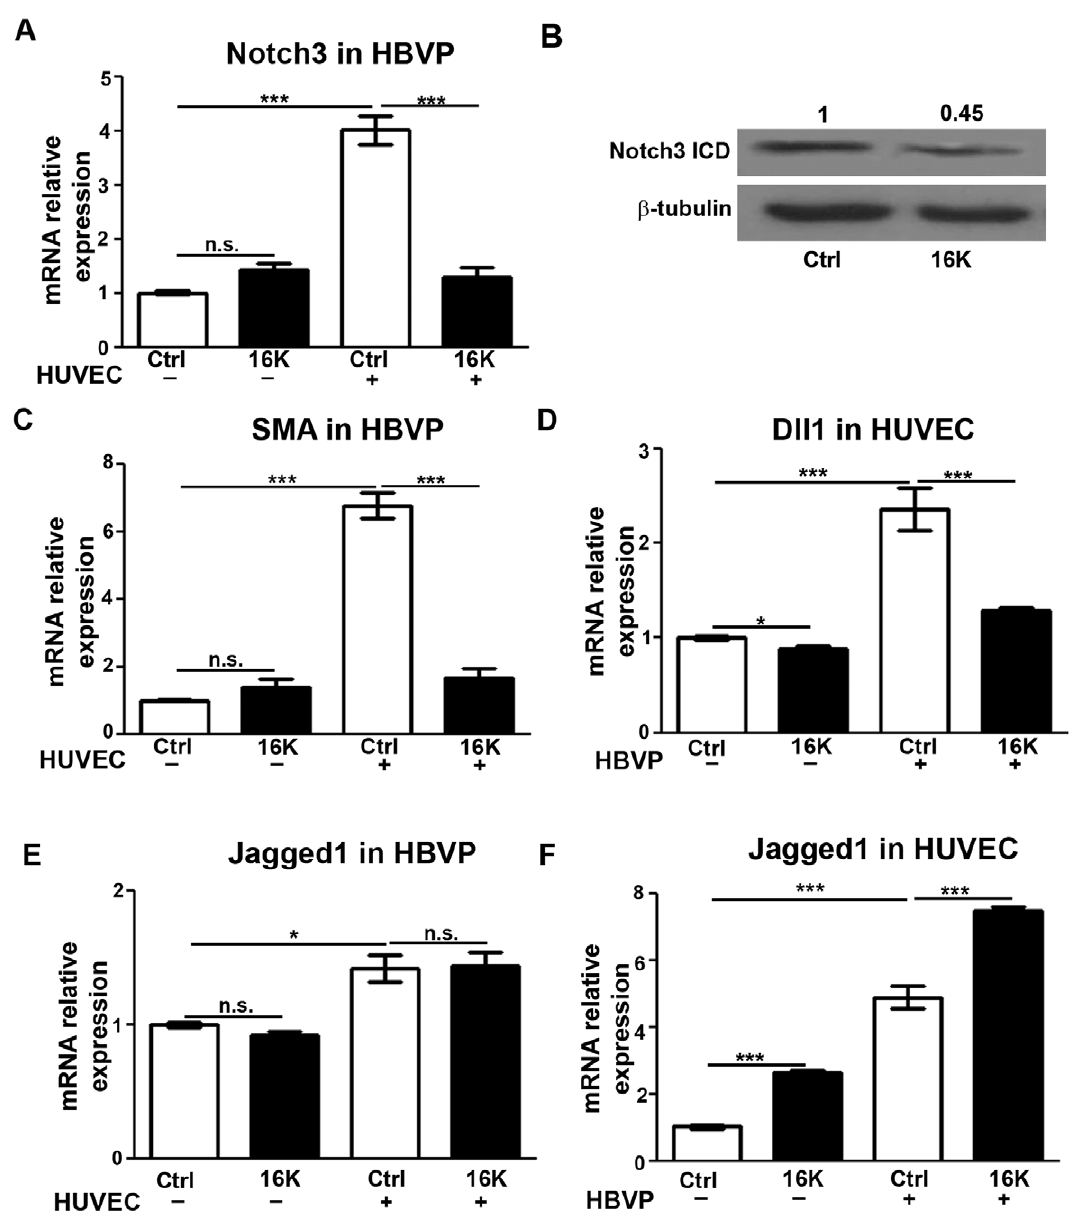
Figure 7. Decreased expression of Notch factors in HUVEC-HBVP cocultures after 16K hPRL treatment. In cultures of HBVP or HUVEC alone, the cells were treated with 100 nM 16K hPRL (16K) for 16 h. HBVP + HUVEC cocultures were seeded and treated as in Fig. 6, but the time spent in coculture was longer (16 h). The two cell populations were then separated prior to qRT-PCR analysis. In HBVP, transcripts of NOTCH3 and aSMA were detected (respectively A and C). Western blot analysis was also performed to detect Notch3 ICD (B). In HUVEC, DLL1 transcripts were detected (D). In HBVP and HUVEC, JAGGED1 transcripts were detected (respectively E and F). The presented data are means 6 SEM, n=3 and are representative of at least two independent experiments. n.s., non significant. ***, P ,